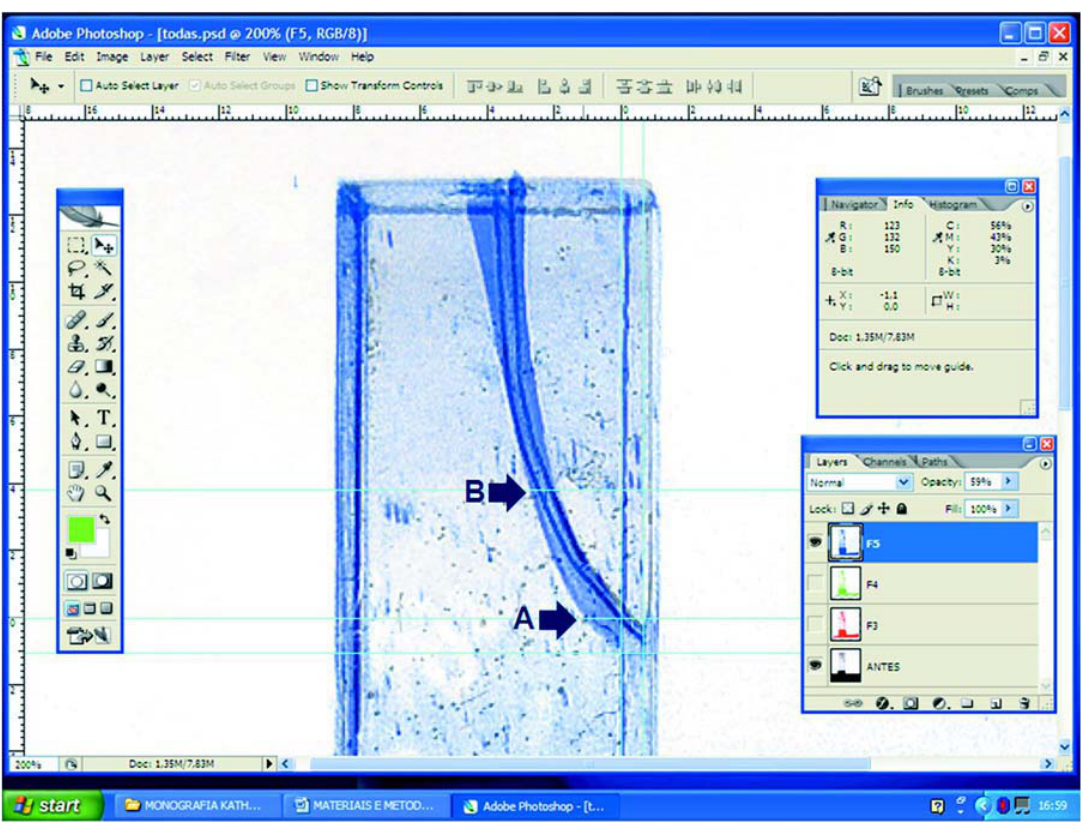
FIGURE 3- Ruler tool being used to exactly locate points A and B. In this case, wear is being measured in point A, which may be observed at the right window TABLE 1 - Wear means (mm) according to instrument size, degree of curvature and curve location